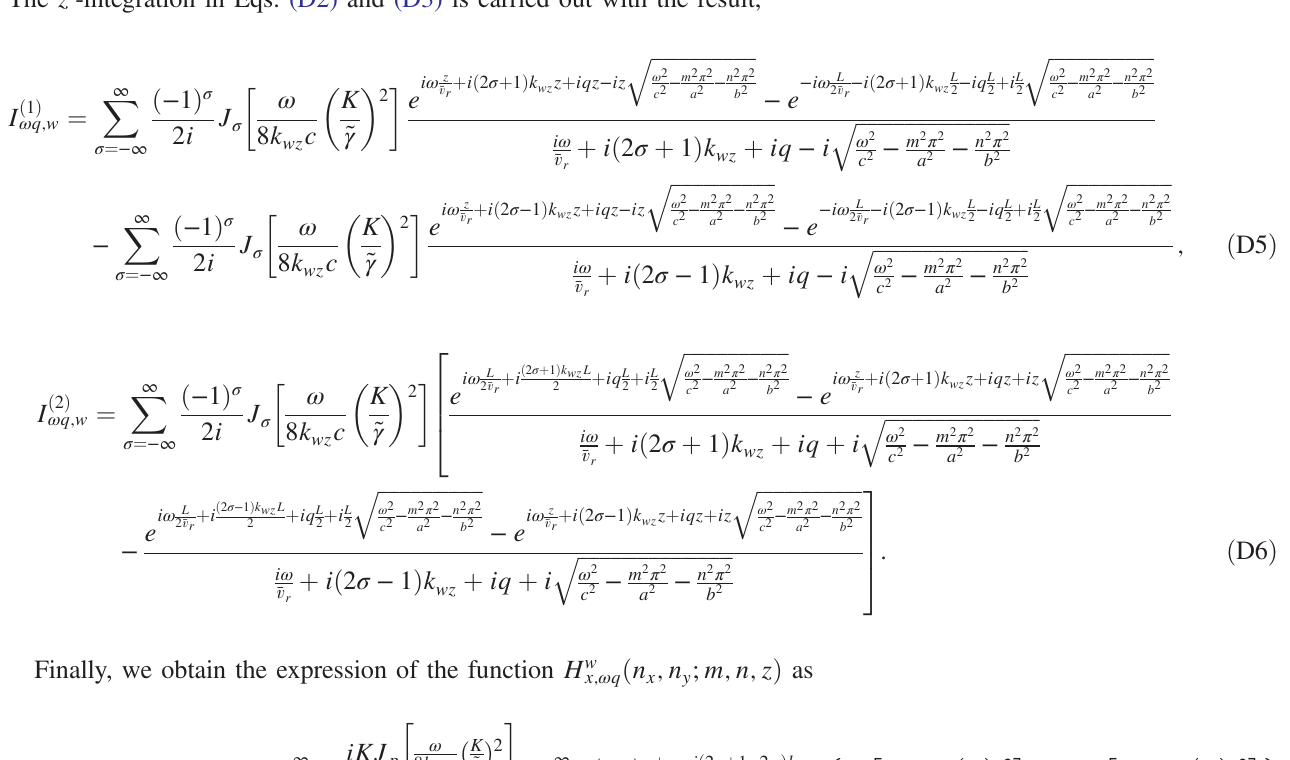
ffiffiffiffiffiffiffiffiffiffiffiffiffiffiffiffiffiffiffiffi ffiffiffiffiffiffiffiffiffiffiffiffiffiffiffiffiffiffiffiffiffiffiffiffiffiffiffi